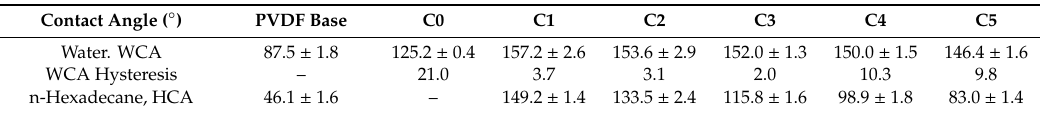
Table 1. Contact angle analysis for polyvinylidene fluoride (PVDF) base coat and different coating samples with different functionalized Al 2 O 3 parameter.